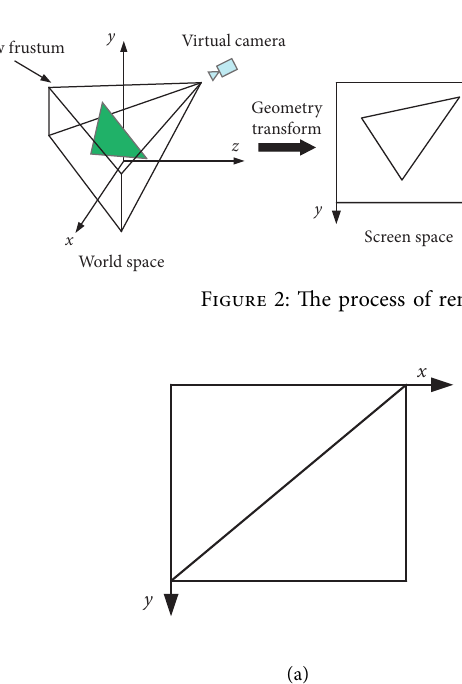
Figure 3: Settings of graphic pipeline. (a) Geometry setup of sound field image on the screen. (b) UVs of the four